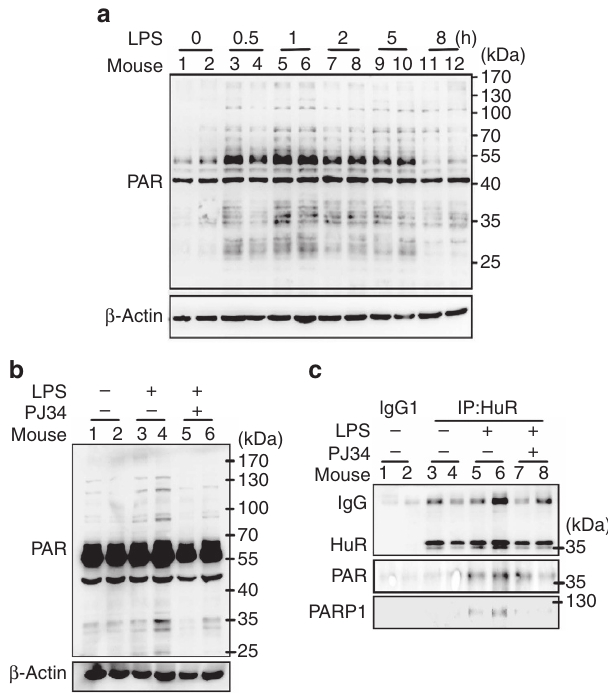
Figure 10 | LPS induces association of PARP1 with and PARylation of HuR in mice lungs. ( a ) LPS exposure increased protein PARylation. Mice were challenged with LPS (50 m g per mouse) through the intranasal route for different time intervals, and then the lungs were excised and levels of protein. ( b ) Activation of PARP is attributed to the increased protein PARylation. Mice were challenged with LPS (50 m g per mouse)